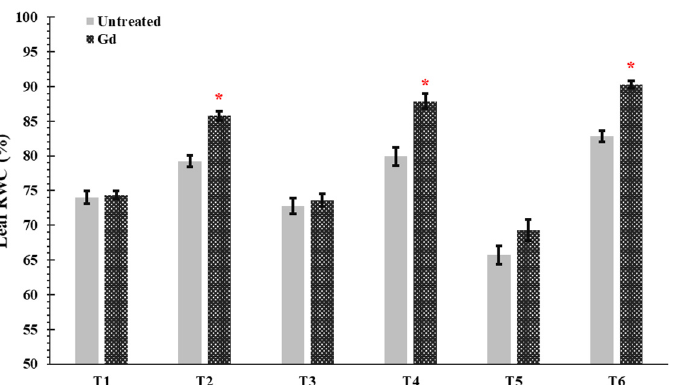
Figure 3. Evaluating the effects of severe water stress (35%-WHC; T1), moderate water stress (50%-WHC; T2), severe nitrogen stress (0 mg N pot − 1 ; T3), moderate nitrogen stress (150 mg N pot − 1 ; T4), combination of severe water stress and moderate nitrogen stress (35% WHC and 0 mg N pot − 1 ; T5), and combination of moderate water stress and moderate nitrogen stress (50% WHC and 150 mg N pot − 1 ; T6) on Leaf relative water contents (RWC) of maize plants inoculated with Gluconacetobacter diazotrophicus Pal5 (Gd) in comparison with untreated plants. Bars represented means of three ( n = 3) replicates with standard errors (SEs). * above bars indicate significance at p < 0.05 and bars without any * are non-significant ( p > 0.05).